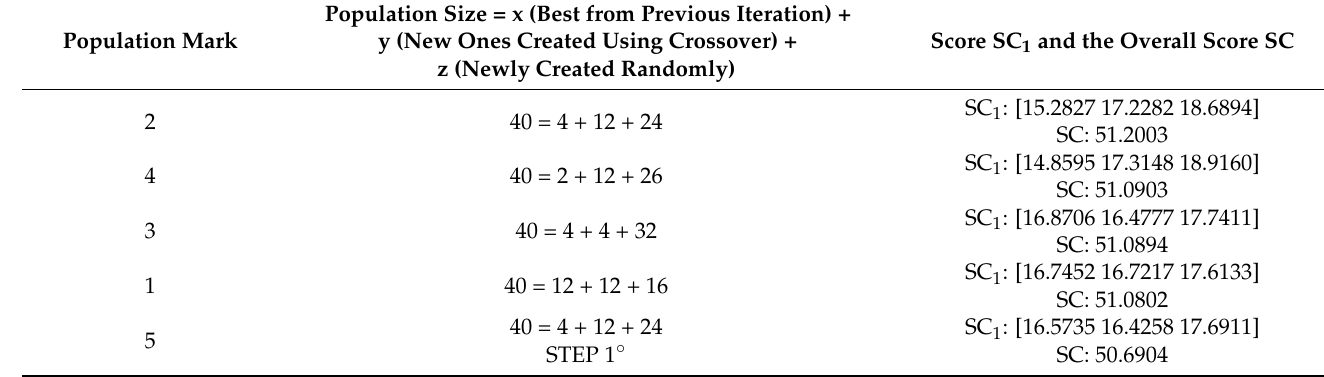
Table 3. Sorted results (according to the total score) for all created populations.